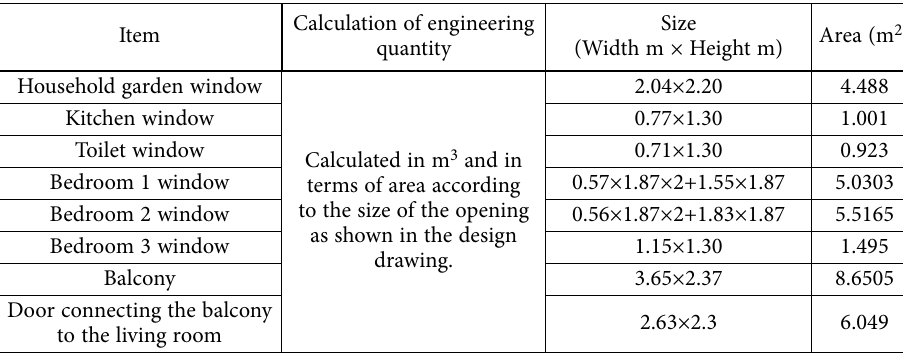
Table 2. Opening size (source: The design